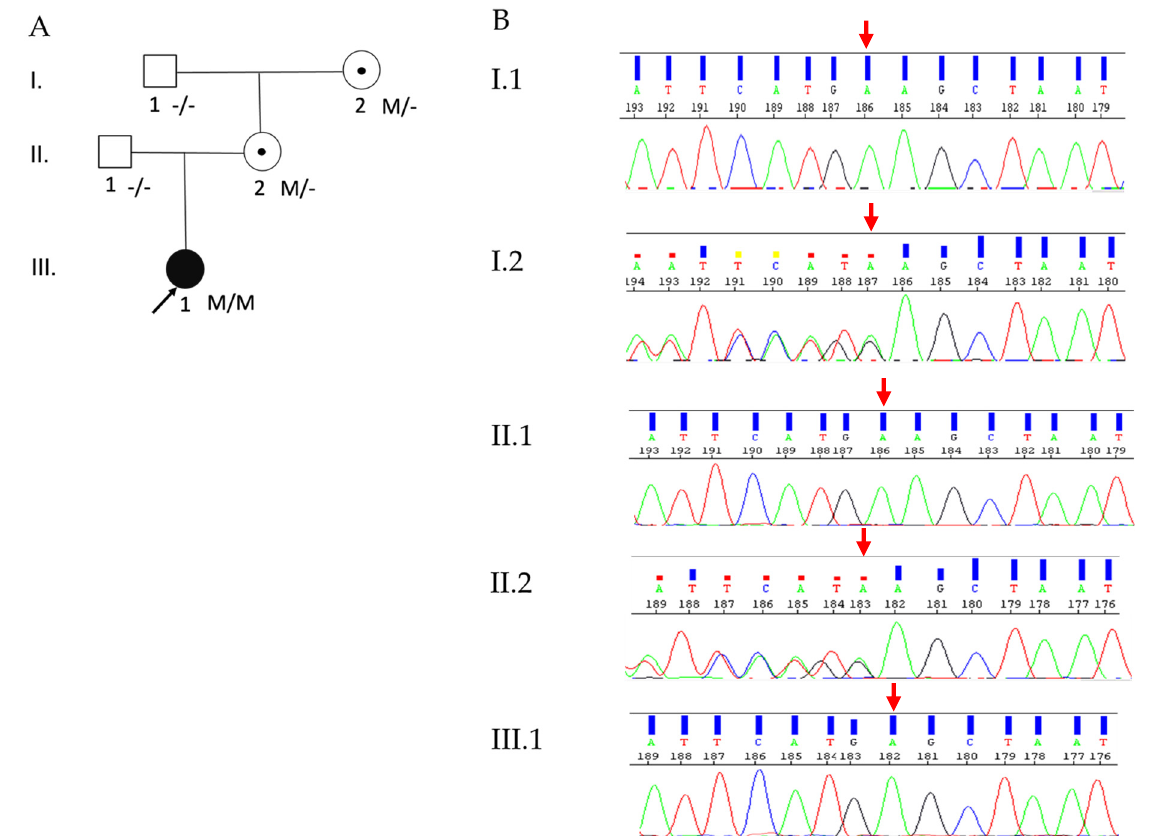
Figure 2. Pedigree and Sanger sequencing profiles: ( A ) Pedigree of the index patient. The black arrow represents the patient. Symbols with central dots indicate heterozygous carriers. Genotypes are indicated below the pedigree symbols. M represents the sequence variant c.5391delA (p.(Ala1798LeufsTer59)) in the DOCK7 gene, and (-) indicates the reference allele. ( B ) Shown are the electropherograms of five family members: the homozygous sequence variant c.5391delA (p.(Ala1798LeufsTer59)) was identified in the index patient (III.1). Her mother (II.2) and the maternal grandmother (I.2) were heterozygous, while her father (II.1) and maternal grandfather (I.1) were non-carriers for this variant. The red arrow indicates the variant position.